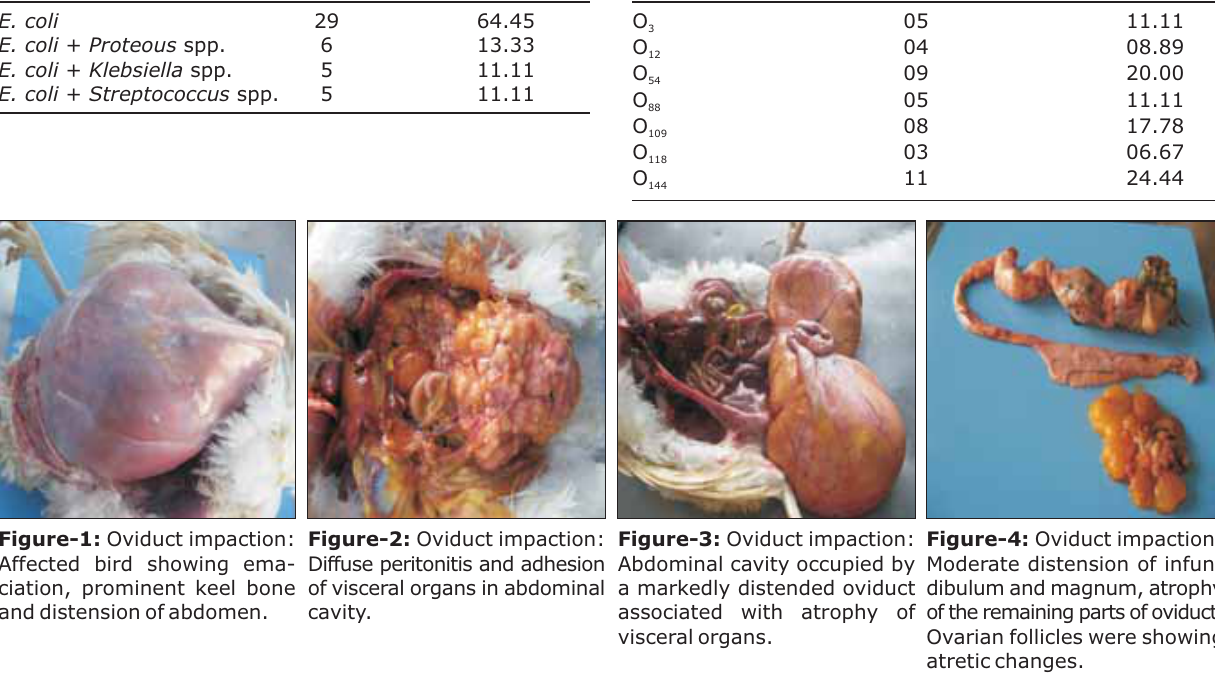
Figure-4: Oviduct impaction: Moderate distension of infun- dibulum and magnum, atrophy of the remaining parts of oviduct. Ovarian follicles were showing atretic